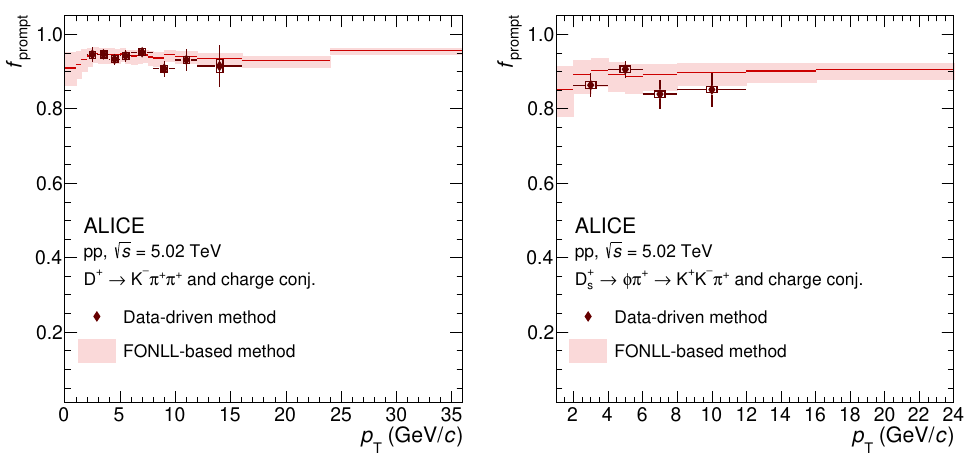
Figure 5 . Comparison of the fractions of prompt D + - and D + -meson raw yields as a function s of p T between the FONLL-based and the data-driven approach. The results from the data-driven method are shown as diamond markers with the error bars (boxes) representing the statistical (systematic) uncertainty. The central values of f prompt from the FONLL-based approach are shown by the continuous line and their uncertainty by the shaded